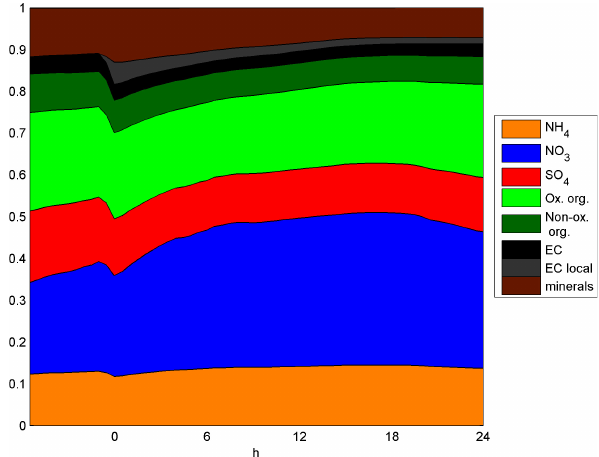
Fig. 6. Modeled average PM 2 . 5 mass fractions from 6h upwind to 24h downwind of Malm¨o, at the surface within the urban plume. The organic mass is divided into non-oxidized (O:C-ratio equal to zero) and oxidized material. In the model the only source for the non-oxidized organic material is low volatile POA